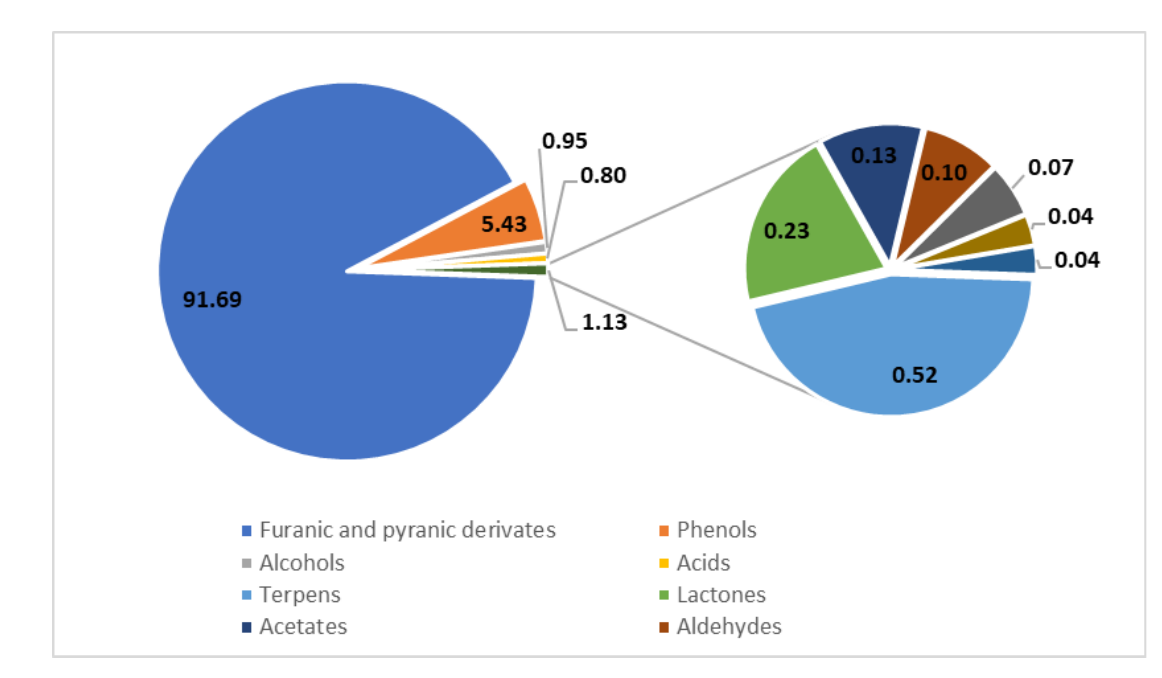
Figure 2. Profile of volatile compounds in balsamic vinegars determined using GC with mass spectrometric detection after solid-phase extraction. The values are presented in % ( w / w ); based on data from [10].